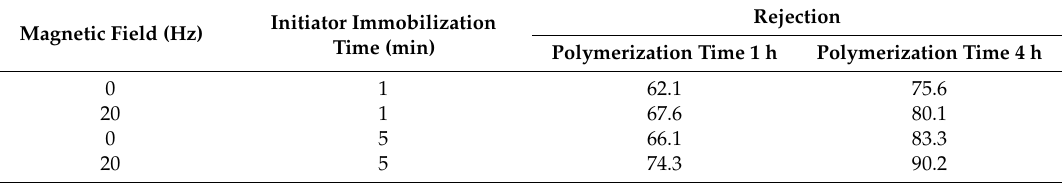
Table 4. BSA rejection (%) by modified membranes.